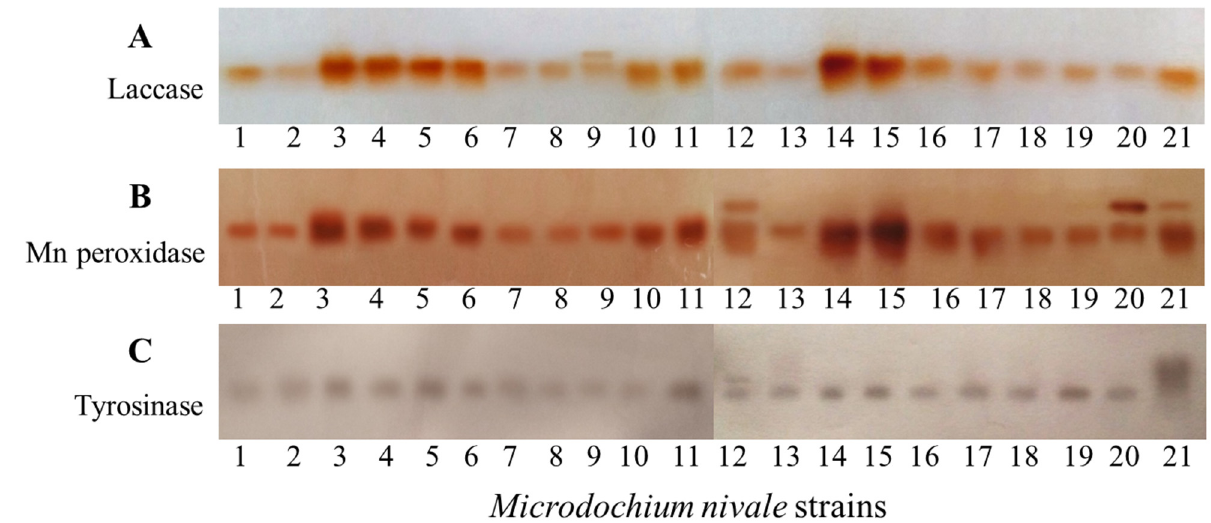
Figure 5. The staining of Microdochium nivale extracellular laccases ( A ), Mn peroxidases ( B ), and tyrosinases ( C ) by corresponding chromogenic substrates (o-dianisidine, 2,6-Dimethoxyphenol + MnSO 4 + H 2 O 2 , and L-dihydroxyphenylalanine, respectively) after separation by native electrophoresis in a 7.5% polyacrylamide gel (PAAG). M. nivale strains were grown in potato sucrose broth medium for 20 days.